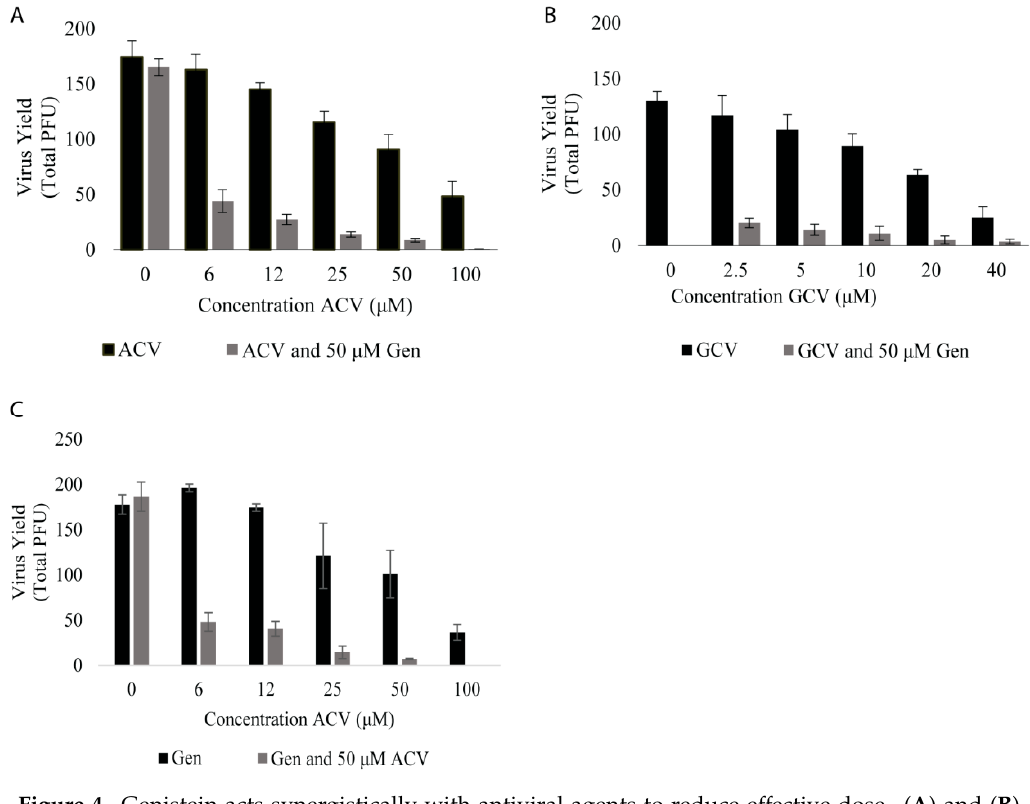
Figure 4. Genistein acts synergistically with antiviral agents to reduce e ff ective dose. ( A ) and ( B ) show the results of virus yield assays, wherein Vero cells were infected with 150 PFU of B virus and 50 µ M of genistein with increasing concentrations of ACV ( A ) or GCV ( B ). ( C ) Vero cells were infected with 150 PFU of B virus and 50 µ M ACV with increasing concentrations of genistein. Total PFU was determined by standard plaque assay. Table 1. Calculated IC 50 Values against B Virus. Agent